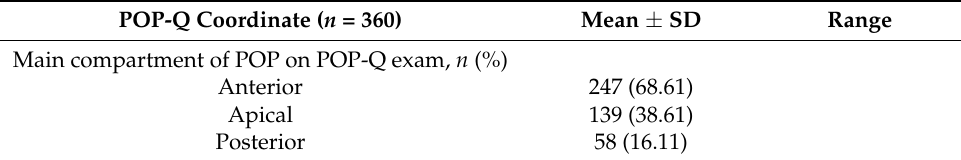
Table 2. Cont. POP-Q Coordinate ( n = 360) Main compartment of POP on POP-Q exam, n (%)